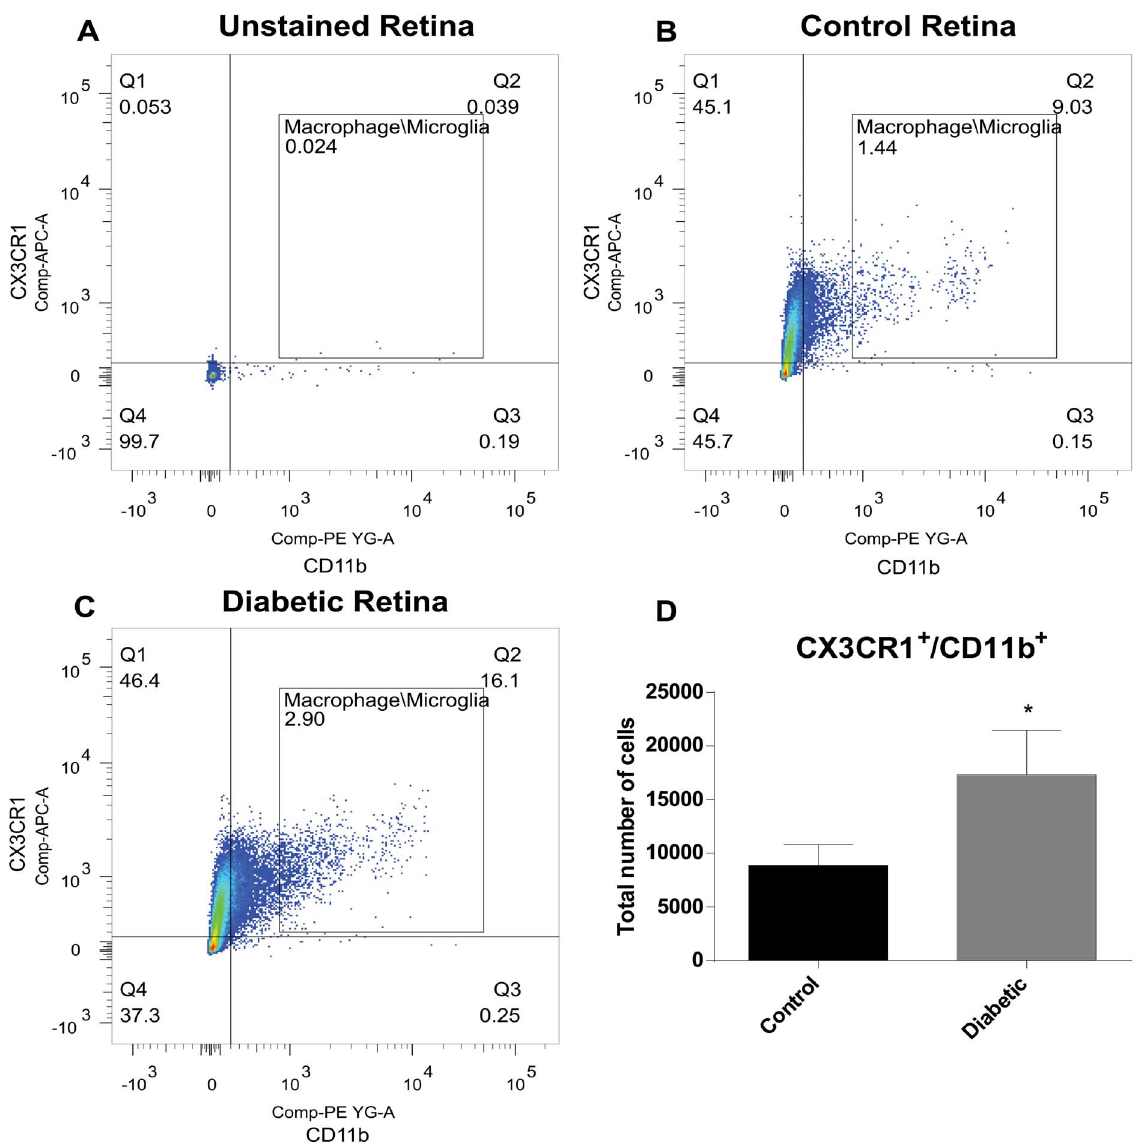
Figure 4. Diabetic mice retinas have significantly higher numbers of CX3CR1 + /CD11b + macrophage/microglia cells. Representative dot plots of flow cytometry analysis of unstained ( A ), stained control non-diabetic ( B ) and 8 week diabetic wildtype mice ( C ) retinal cell suspensions. Gating was done to include monocyte/macrophage and microglia cells labelled CX3CR1 + /CD11b + . Graphic representation of the total number of CX3CR1 + /CD11b + cells in diabetic mice demonstrates a two-fold increase in comparison to non-diabetic ( D ). * Significantly greater than control non- diabetic (p , 0.05).